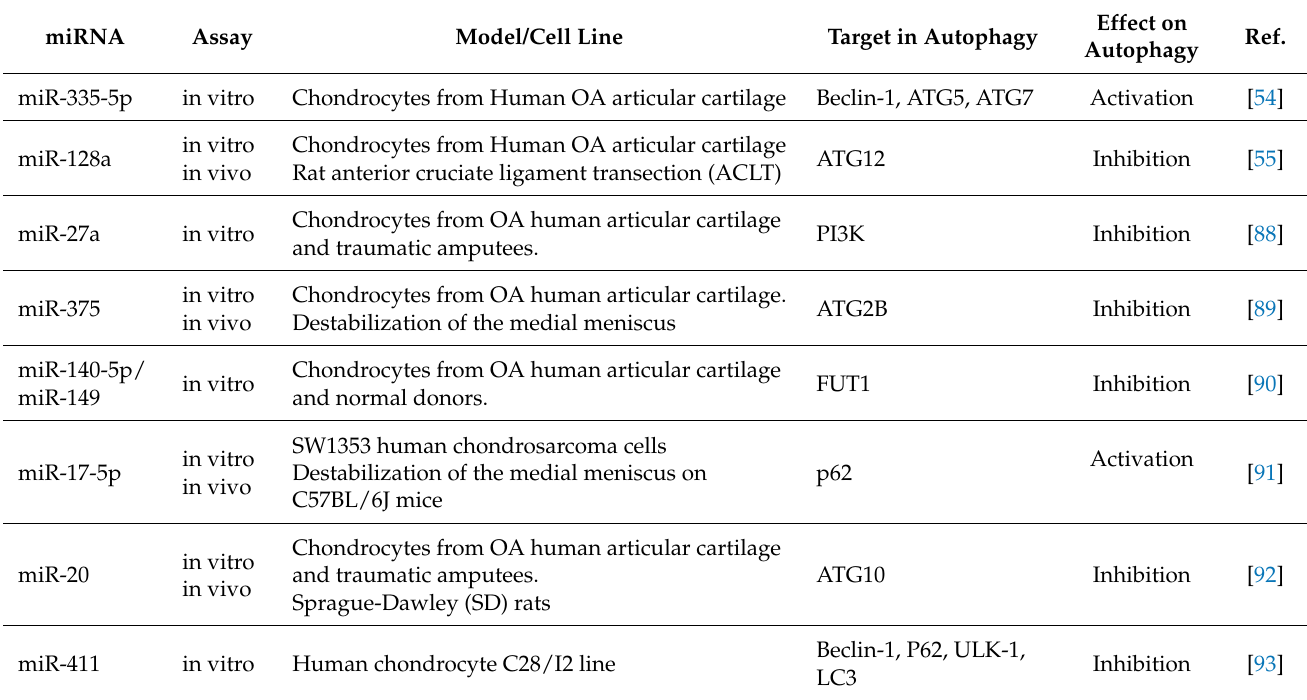
Table 2. Regulation of autophagy by miRNAs in Osteoarthritis